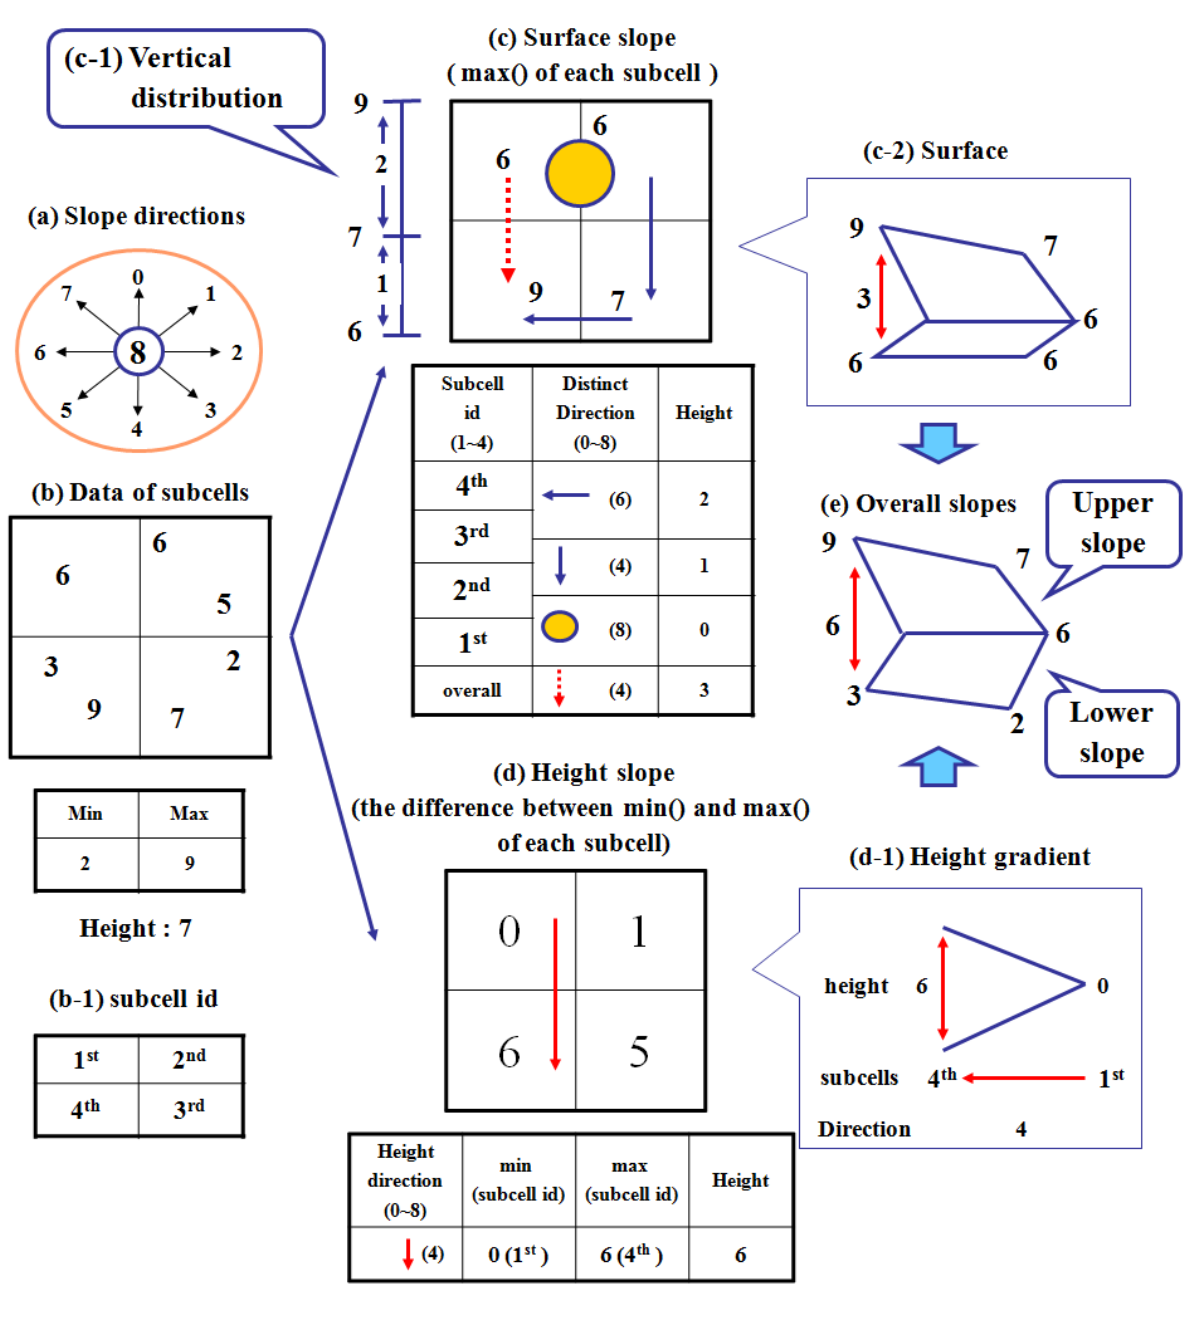
Figure 4. The layered slopes for data abstraction in a